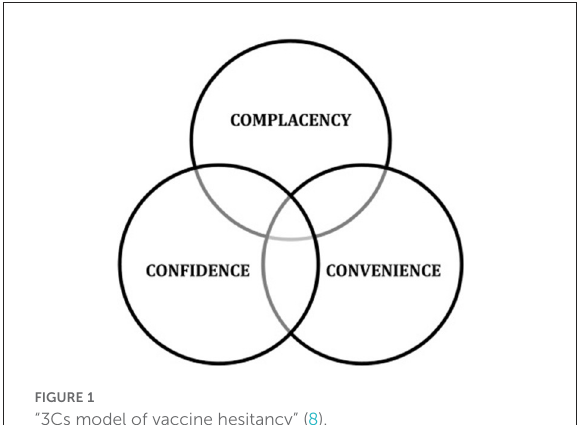
FIGURE1 “3Cs model of vaccine hesitancy”